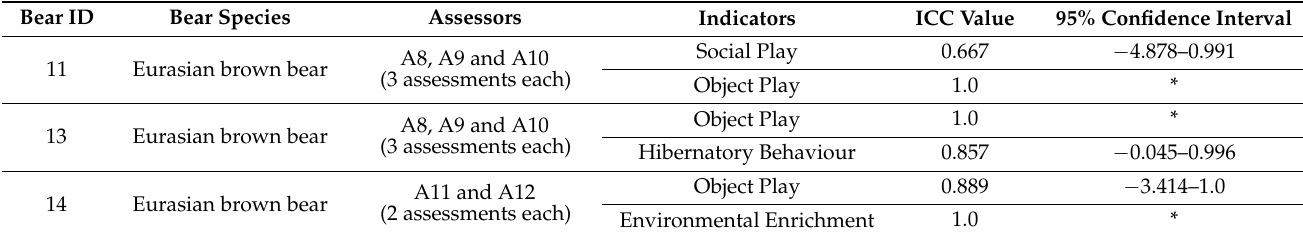
Table 4. Item Reliability for indicators including their 95% Confidence Intervals.